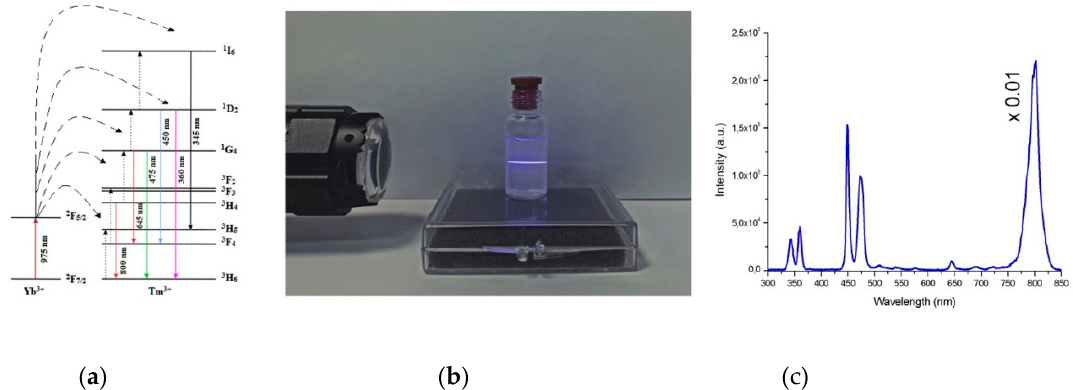
Figure 2. ( a ) Energy level diagram of upconversion nanoparticles (UCNPs): NaYF 4 : Yb 3 + , Tm 3 + ; ( b ) Visible spectral range image of UCNPs photoluminescence in hexane; ( c ) Corrected apparatus function spectrum of the UCNPs under near-infrared (NIR) excitation at 975 nm at intensity 10 W / cm 2 (line centered at 800 nm multiplied by coefficient 0,01).